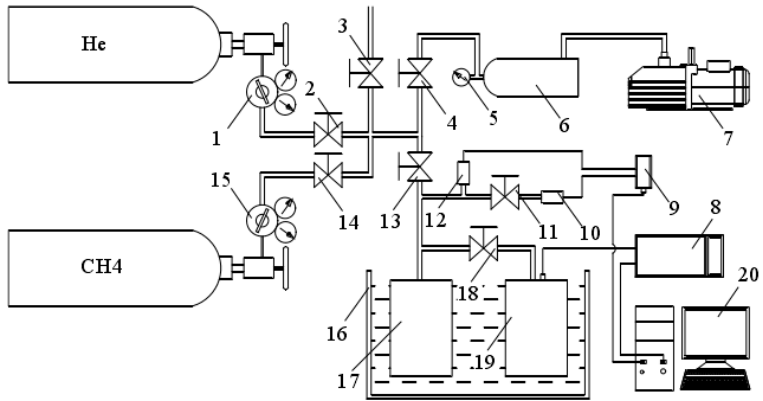
Figure 2. Schematic diagram of the mixed coal sample isotherm test. 1—He pressure reducing valve;